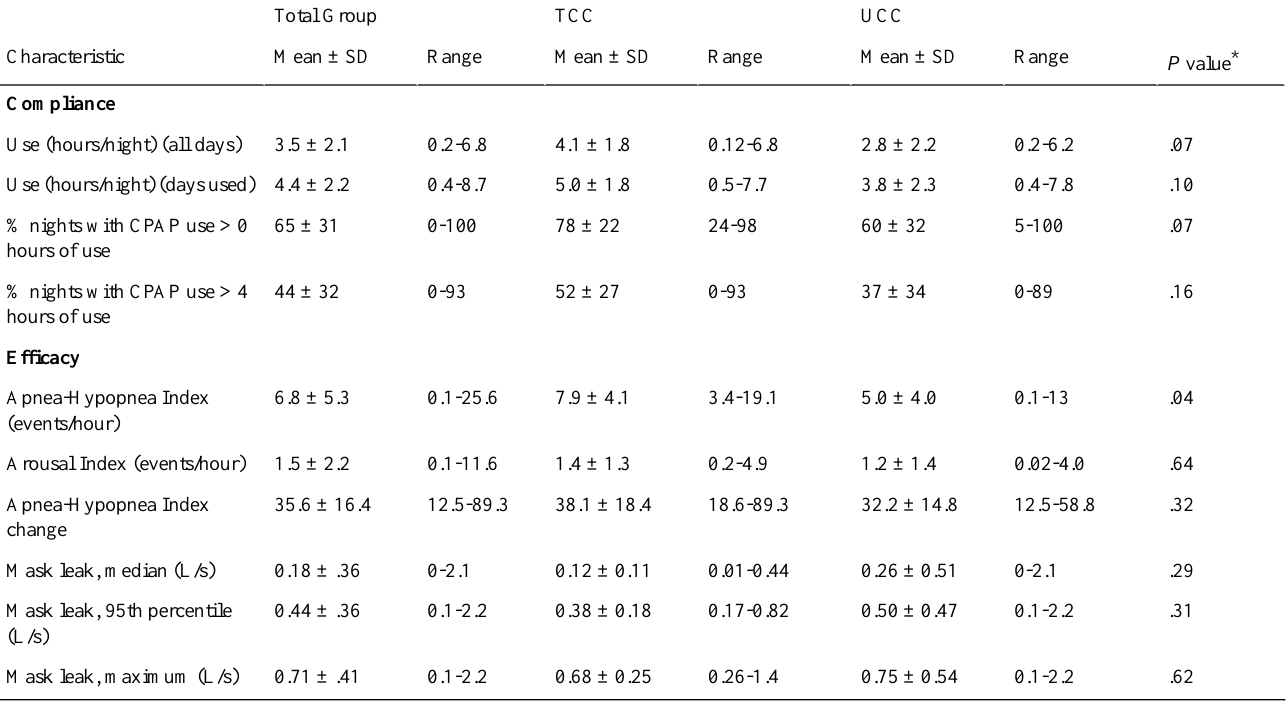
Table 5. CPAP compliance and efficacy data summary, postintervention UCCTCCTotal